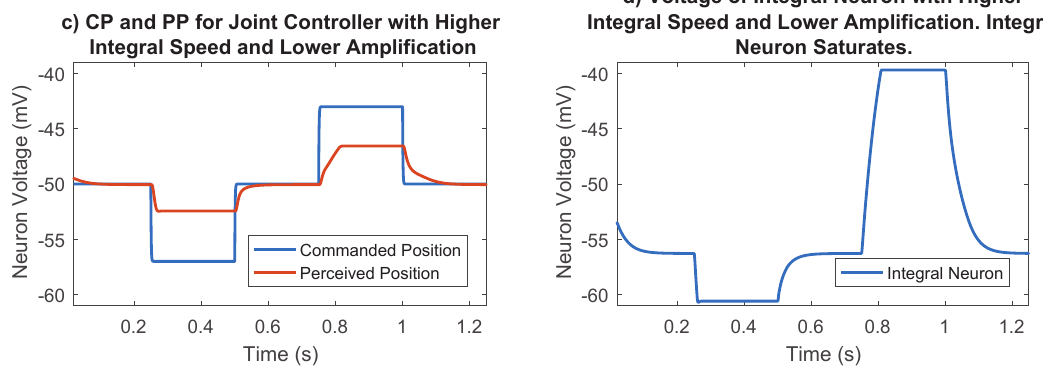
Figure 8. Importance of synaptic strength to the integral neuron in joint position control. ( a ) Commanded position and perceived position for the selected case. Lower integration speed and larger amplification tuned during the optimization process results in good reference tracking; ( b ) Voltage of integral neuron for the selected case. Lower integral speed results in voltages far away from saturation points; ( c ) Commanded position and perceived position for the undesirable case. The joint never gets to its commanded position because the integral neuron saturates; ( d ) Voltage of integral neuron for the undesirable case. Higher integration speeds cause the integral neuron to reach the synaptic thresholds, losing its ability to send